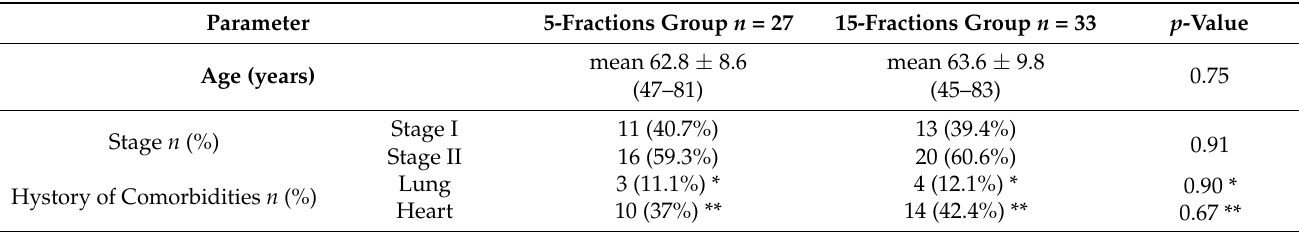
Table 1. Age, stage and comorbidity distribution in two observed